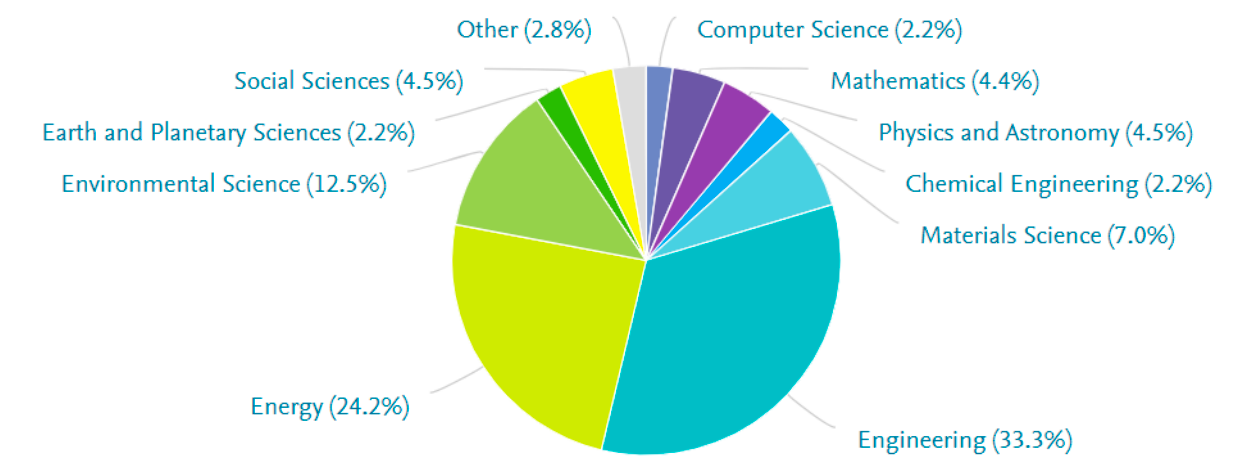
Figure 24. Publications by subject area (accessed on 21 January 2022).